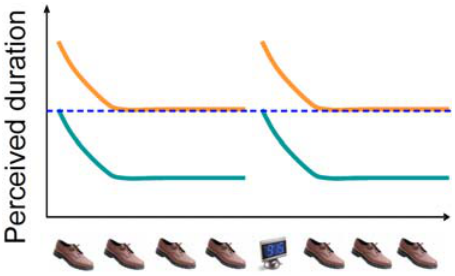
Figure 6. Duration relativity. While the prevailing view of the duration illusion is that the first and oddball stimuli experience duration dilations (red lines), it is equally feasible that the successive, repeated stimuli are experiencing duration contractions (green